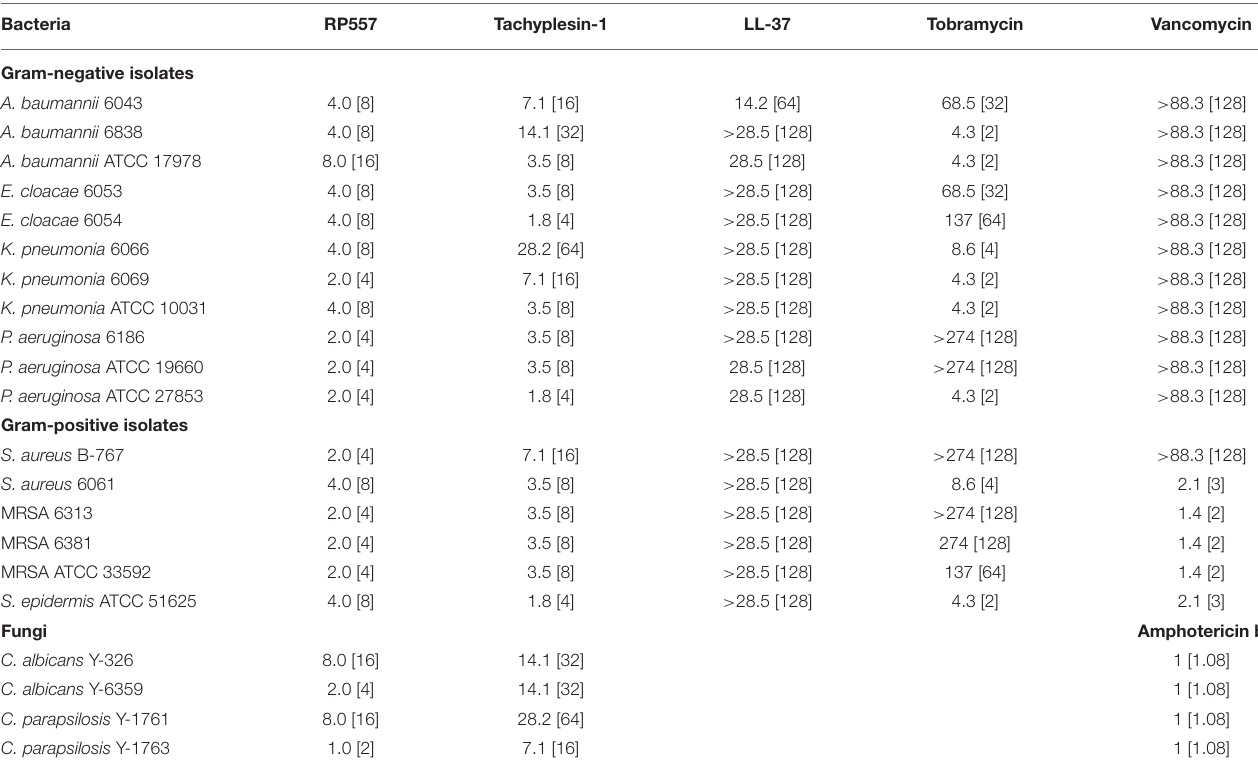
TABLE 1 | Minimum Inhibitory Concentration (MIC, µ M, [ µ g/mL]) evaluation of RP557, LL-37, tobramycin and vancomycin against planktonic gram-positive and gram-negative bacteria and fungi.